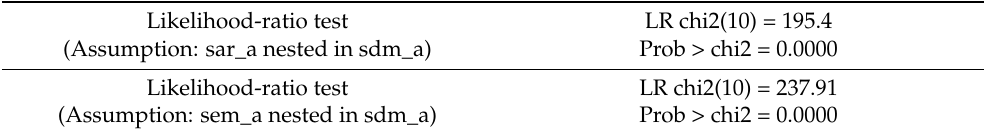
Table 3. The result of LR test. Likelihood-ratio test LR chi2(10) =